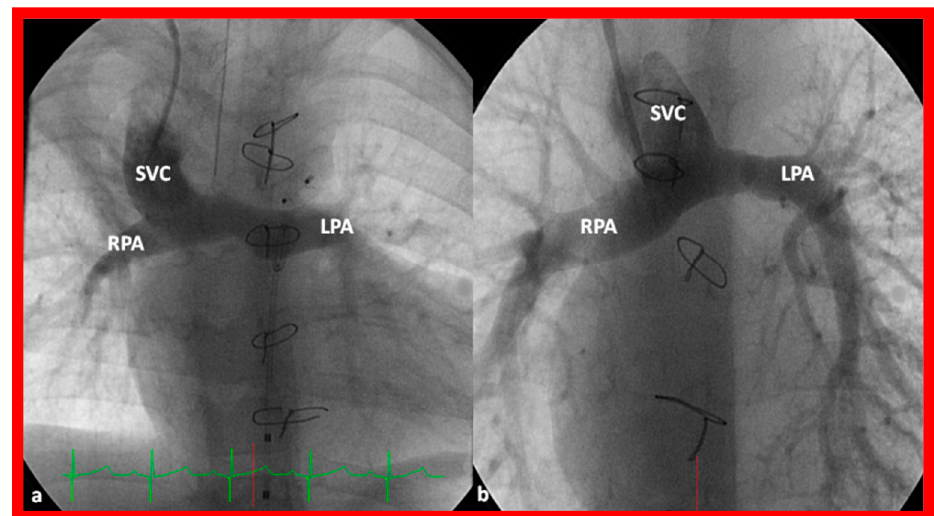
Figure 6. Selected cine frames demonstrating a bidirectional Glenn anastomosis in two different patients, ( a , b ). Unrestricted blood flow from the superior vena cava (SVC) to the left (LPA) and right (RPA) pulmonary arteries is seen. Sternal wires from a previous operation are visualized (not marked). Reproduced from [63].